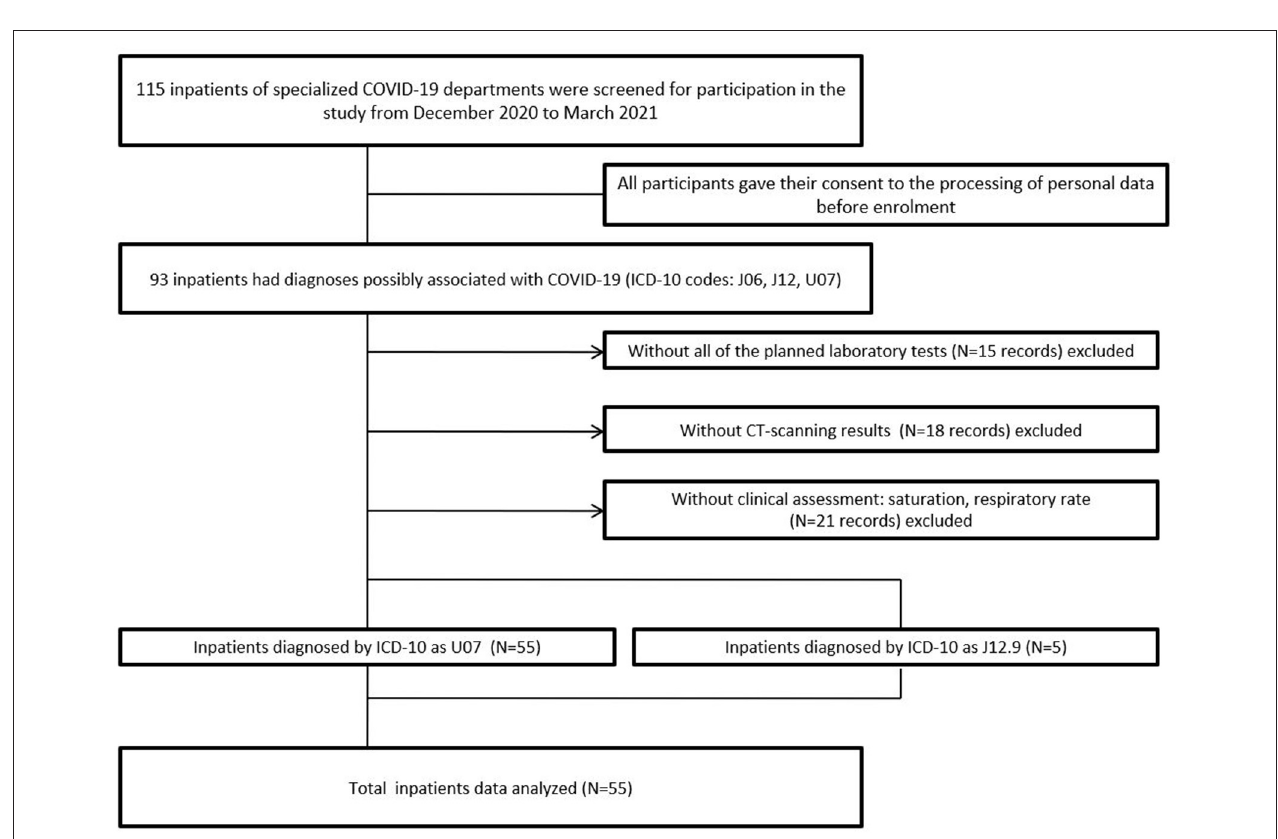
FIGURE 1 | Flowchart of participant